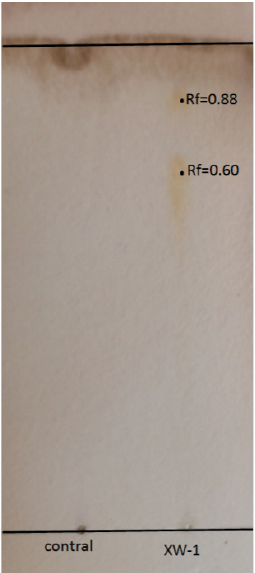
Figure 2. Phylogenetic tree of Planococcus sp. XW-1 based on 16S rRNA gene sequences. The phylo- genetic tree revealed the relationship between members of the genus Planococcus and related genera.